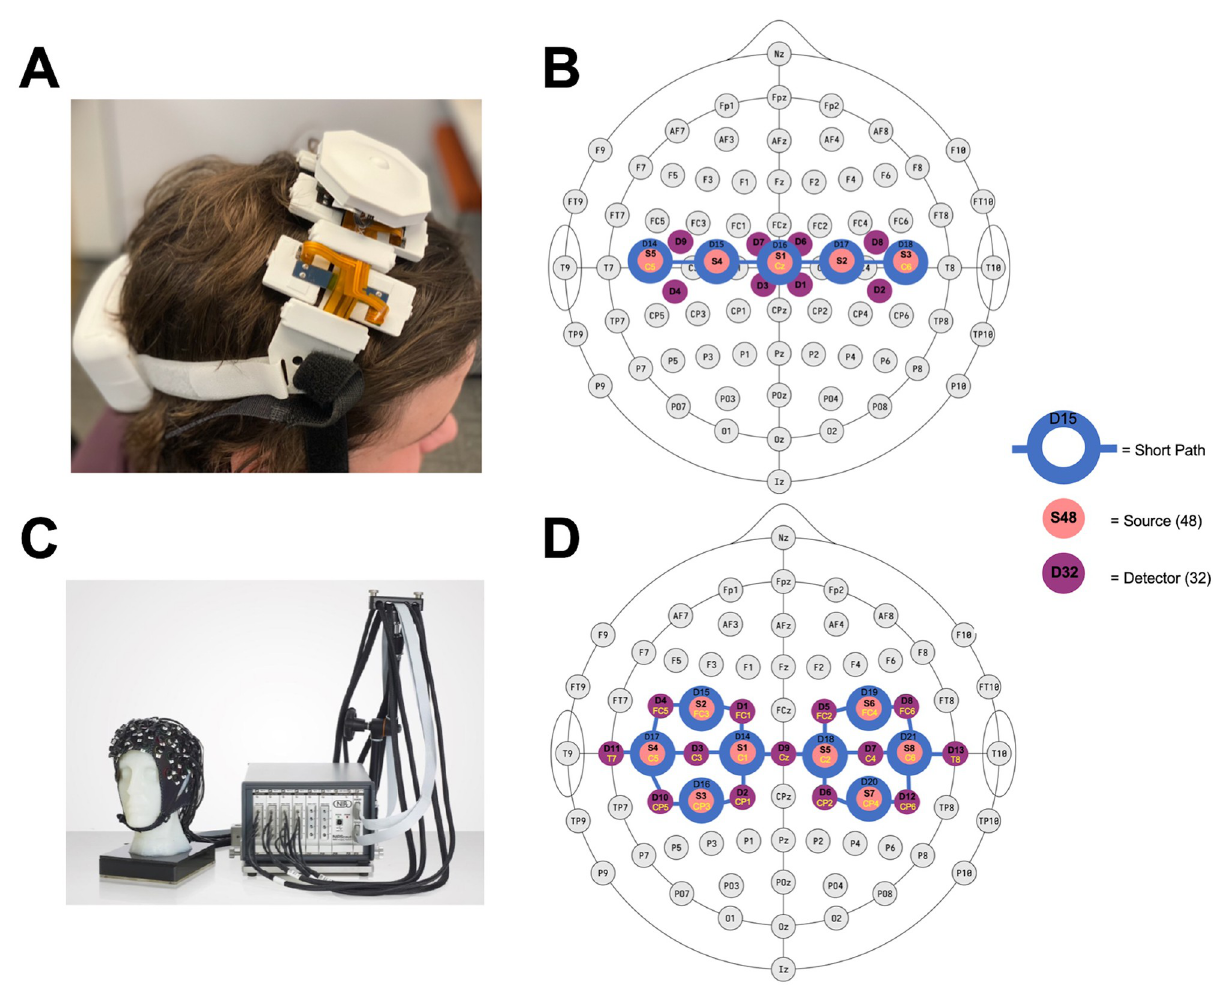
Fig 1. fNIRS systems used in present study. A: prototype fNIRS device. B: Array of optical components included in the fNIRS prototype. The central three detectors (being 3cm from 4 long-path LEDs) enabled 4 measurement locations each, with the two detectors on either end (being 3cm from 2 long-path LEDs) enabling two, resulting in a total of 16 measurement locations. C: NIRScout device. D: the NIRScout’s array of optical components supporting 28 measurement locations.